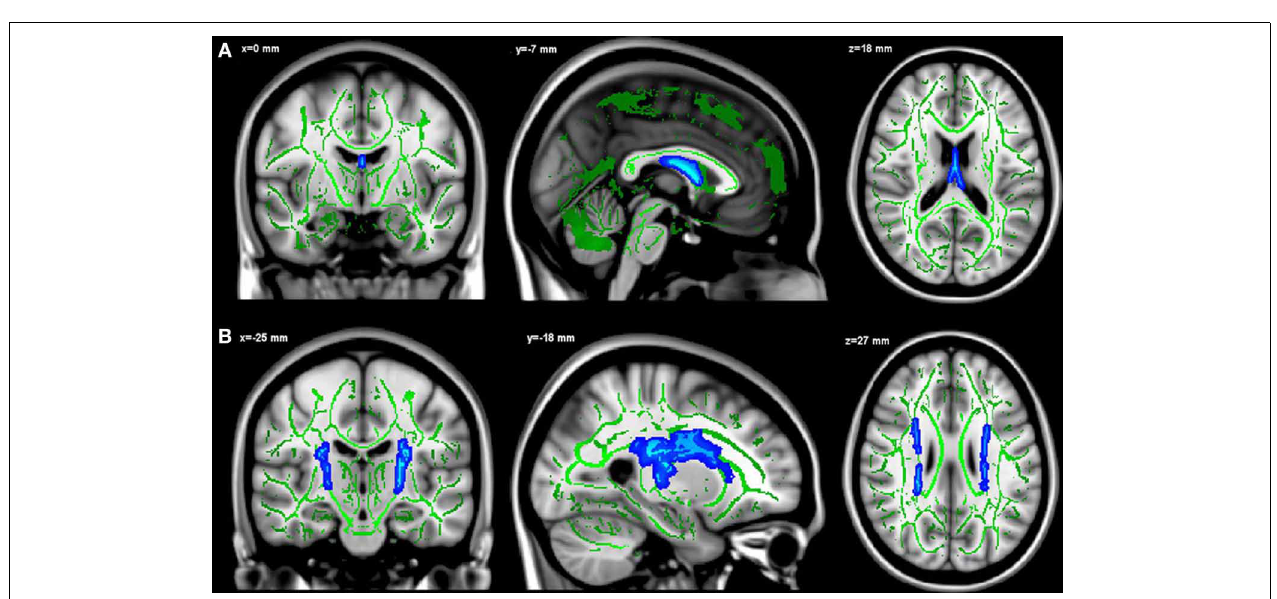
FIGURE 1 | Negative relationship between age and FA values. Significant voxels are shown in blue. The results are displayed at p < 0 . 05, TFCE corrected and overlaid simultaneously on the mean FA skeleton (green) and the MNI template.